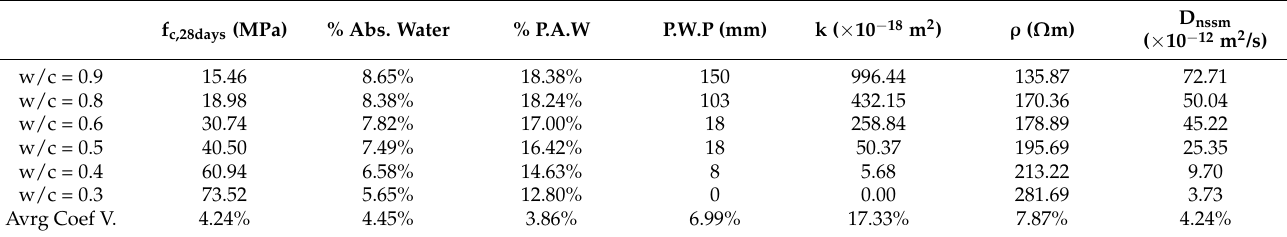
Table 2. Average values of the standardized test